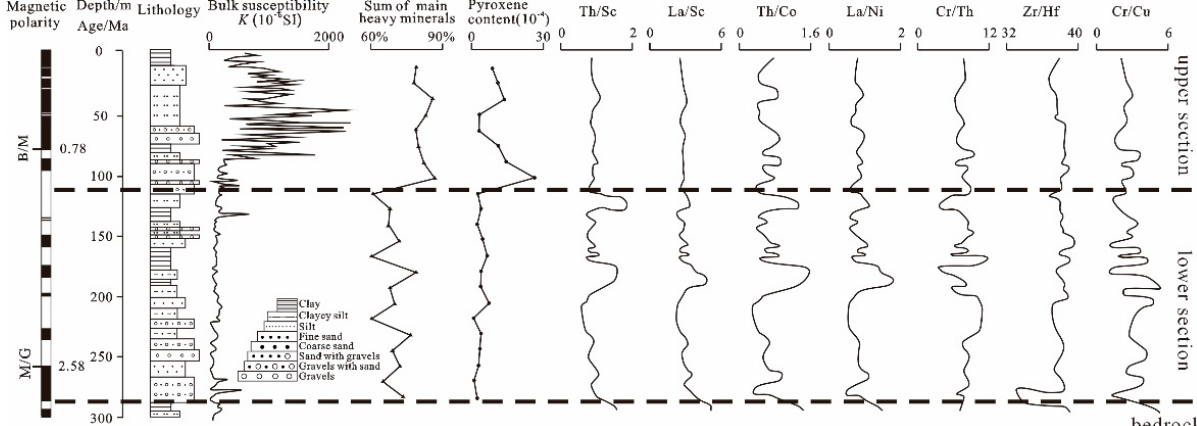
Figure 7. Variation in provenance indicator values of the Zhoulao core. Lithology, magnetic characteristics, heavy mineral assemblage, pyroxene content, and trace-element patterns suggest that the sediment provenance underwent a major change at a depth of ~110 m in the Zhoulao core.